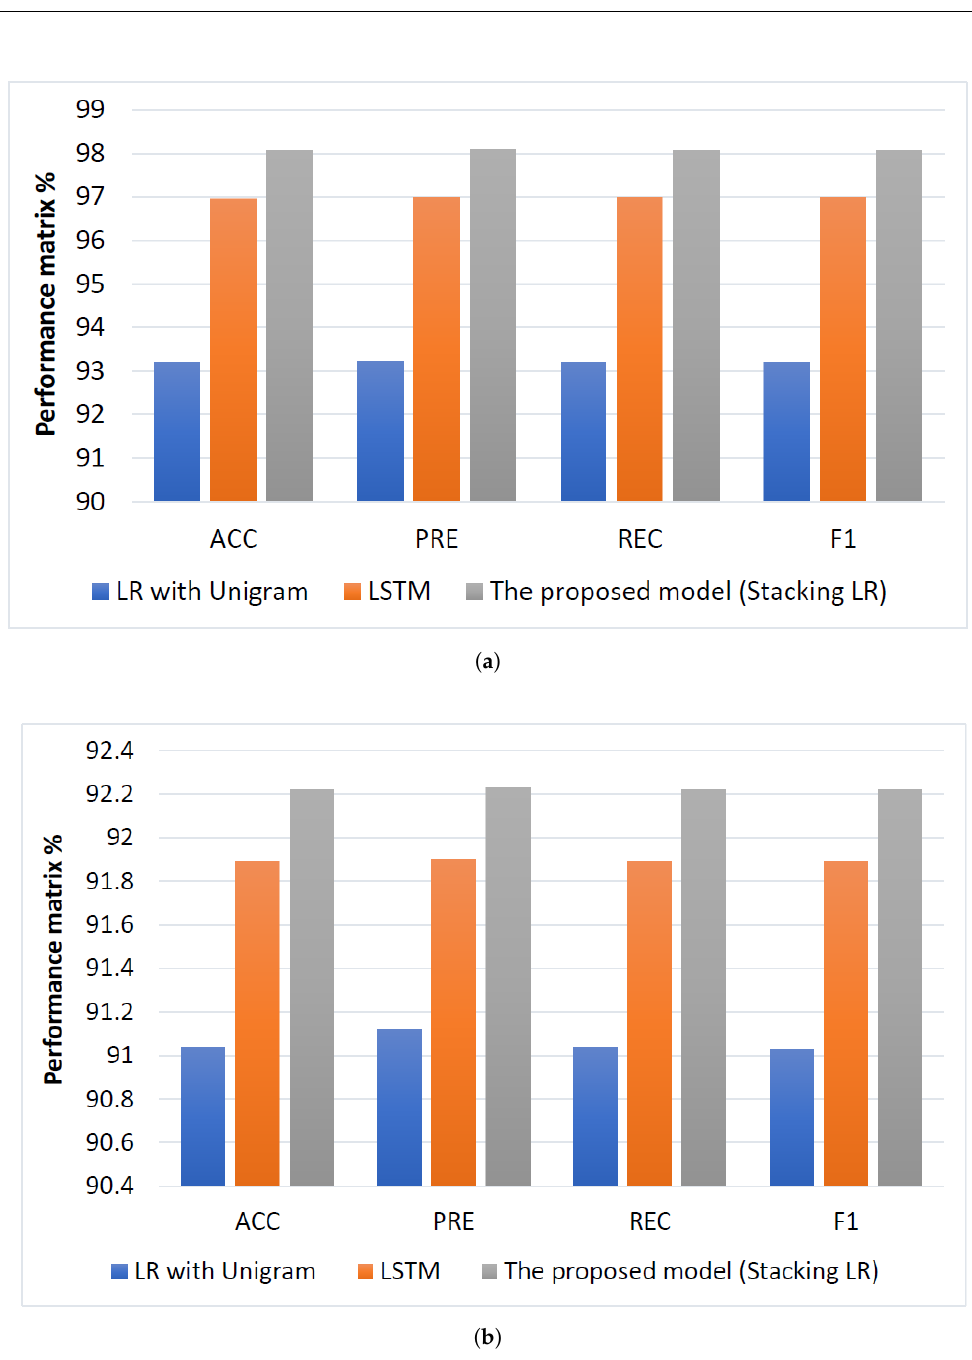
Figure 11. Comparison of performance the best models for ASTC dataset, ( a ) Cross-validation performance and ( b ) testing